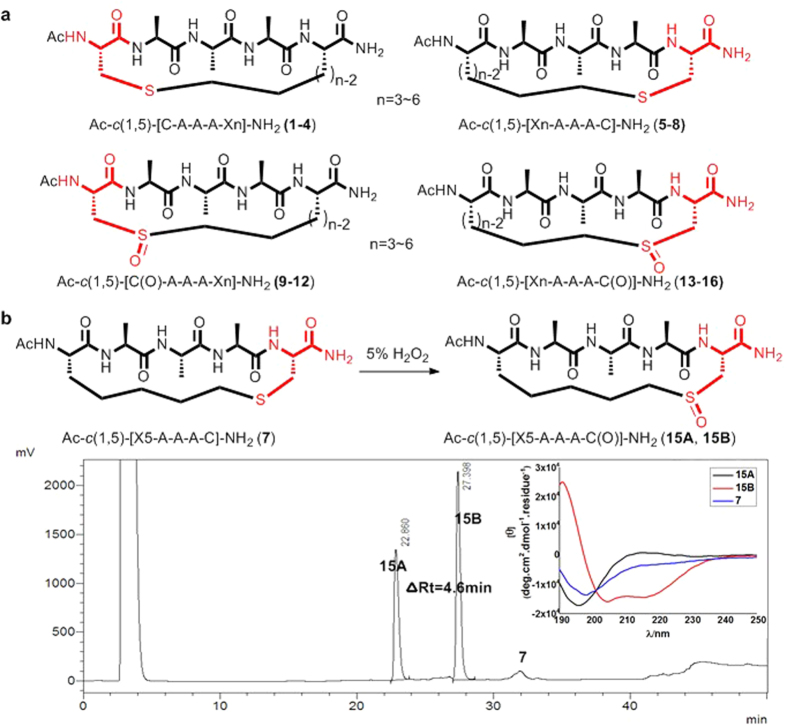
(a) Sequence of peptide 1-16, where A is L-alanine, C is cysteine, c(x, y) signifies cross-link forming amino acid. (b) Oxidation of peptide 7 to (S)-15A and (R)-15B. HPLC spectrum of the oxidation reaction mixture. CD spectroscopy was performed in 10 mM PBS (pH = 7.4) buffer at 25 °C.